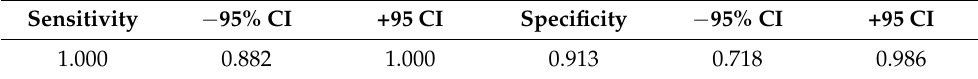
Table 6. Estimated sensitivity and specificity for combined model of the plasma and peritoneal